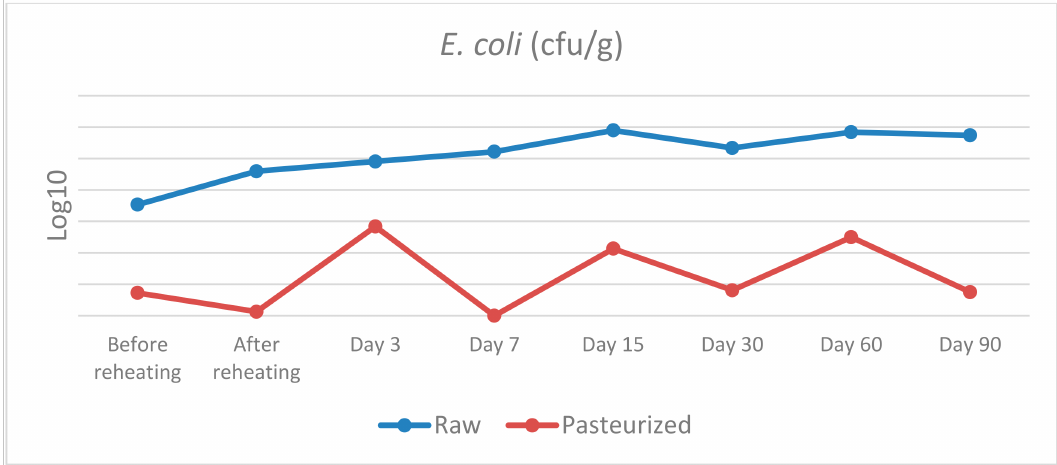
Figure 2. E. coli counts in raw and pasteurized curd and cheese samples.